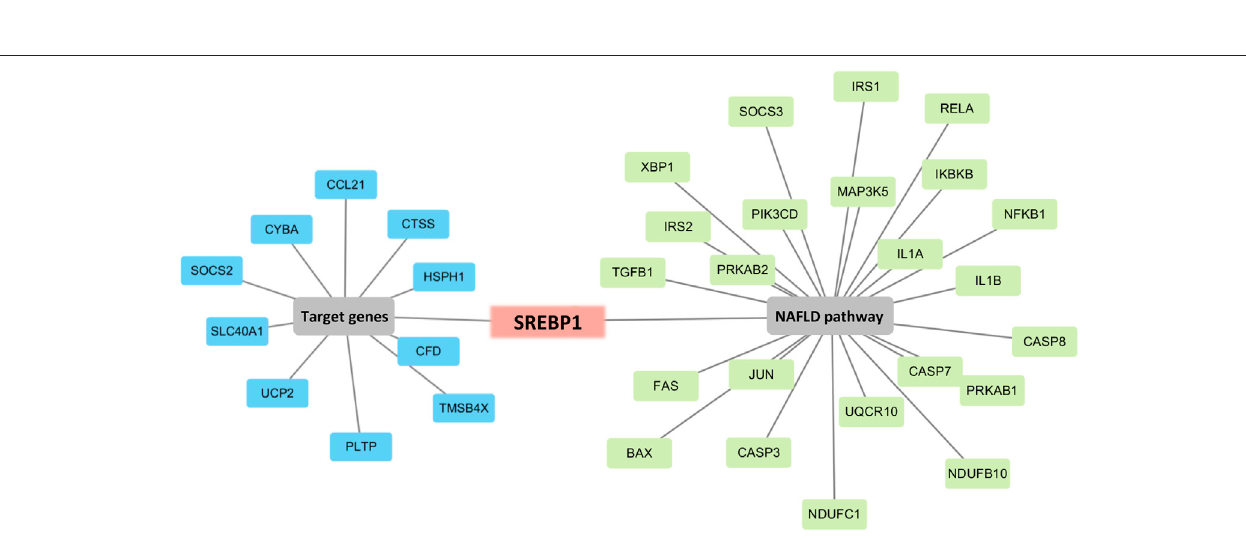
Frontiers in Pharmacology |